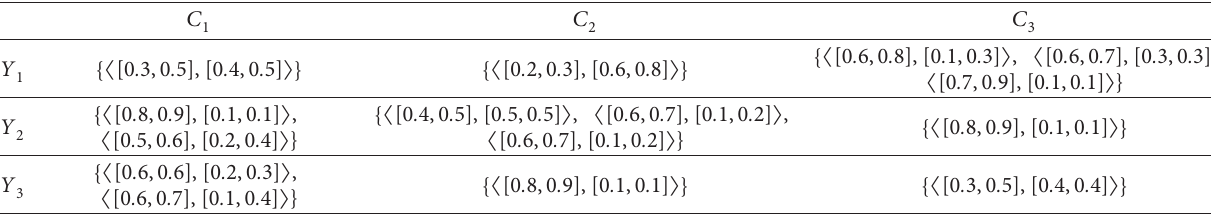
Table 4: IVPHFDM N ( 1 ) .